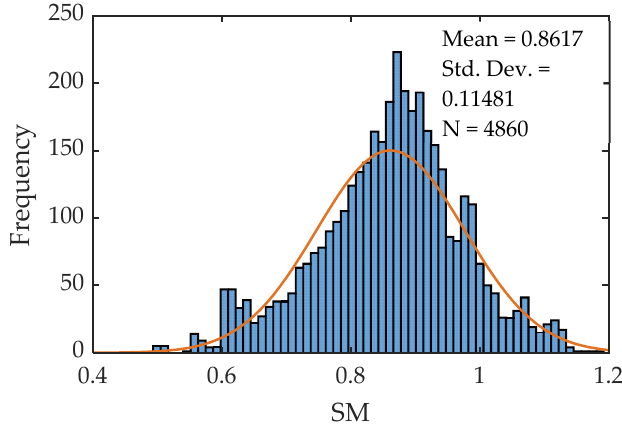
Figure 6. Histogram and distribution of SM data [37].